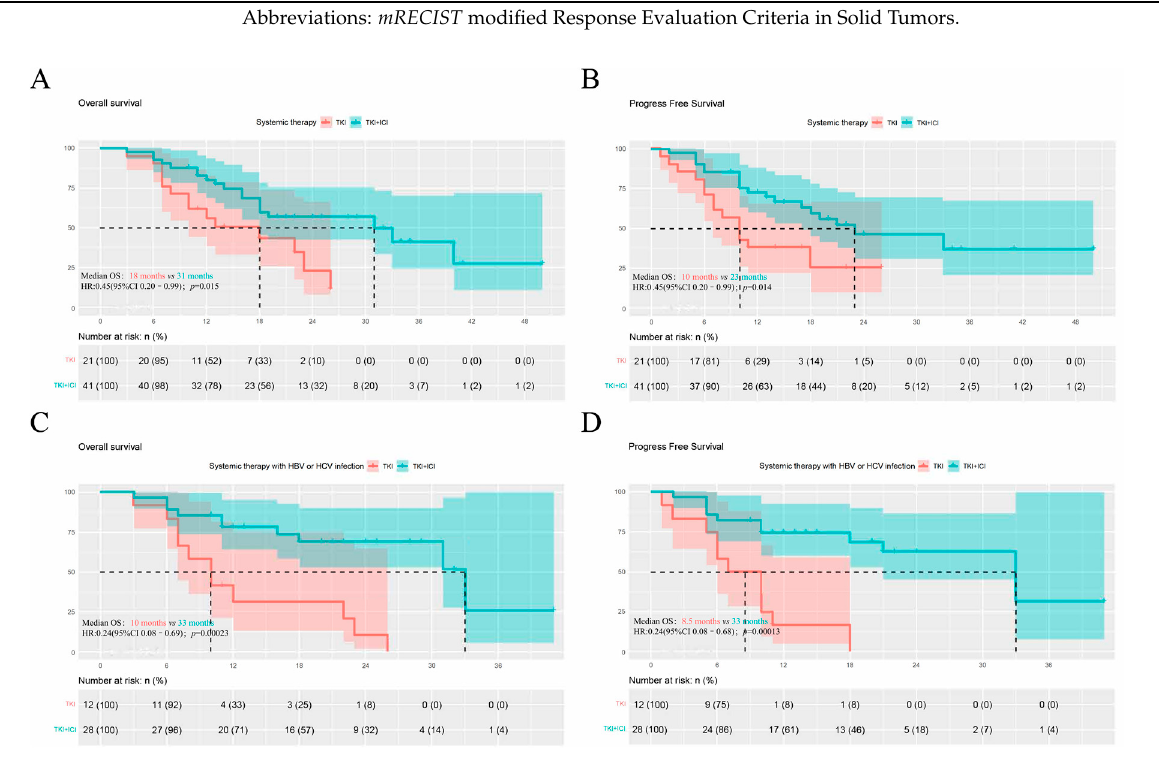
Figure 1. Kaplan-Meier curve of overall and progression-free survival ( A ) Overall survival for TKIs mono-therapy and TKIs plus ICIs groups ( B ) Progression-free survival for TKIs mono-therapy and TKIs plus ICIs groups ( C ) Overall survival for TKIs mono-therapy and TKIs plus ICIs groups with HBV/HCV infection ( D ) Progression-free survival for TKIs mono-therapy and TKIs plus ICIs groups with HBV/HCV infection. Table 2. Best response of TKIs and TKIs + ICIs, N = 62 (%).